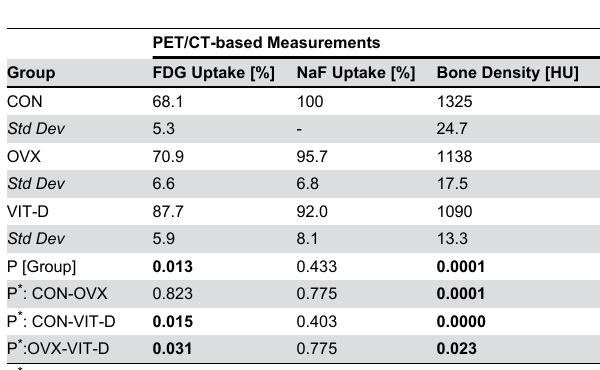
Table 1. PET/CT based 18FDG and Na18F uptake and bone density values for